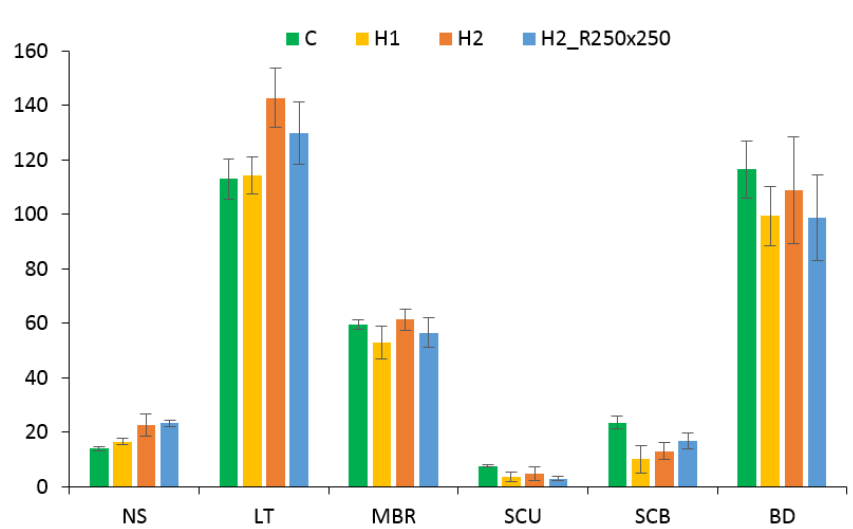
Figure 8. Morphology traits of plants grown in different experiment variants; NS = number of stomata, LT = leaf thickness (µm), MBR = main bundle radius (µm), SCU = sclerenchyma cells–top, SCB = sclerenchyma cells – bottom, BD = bundles distance (µm).